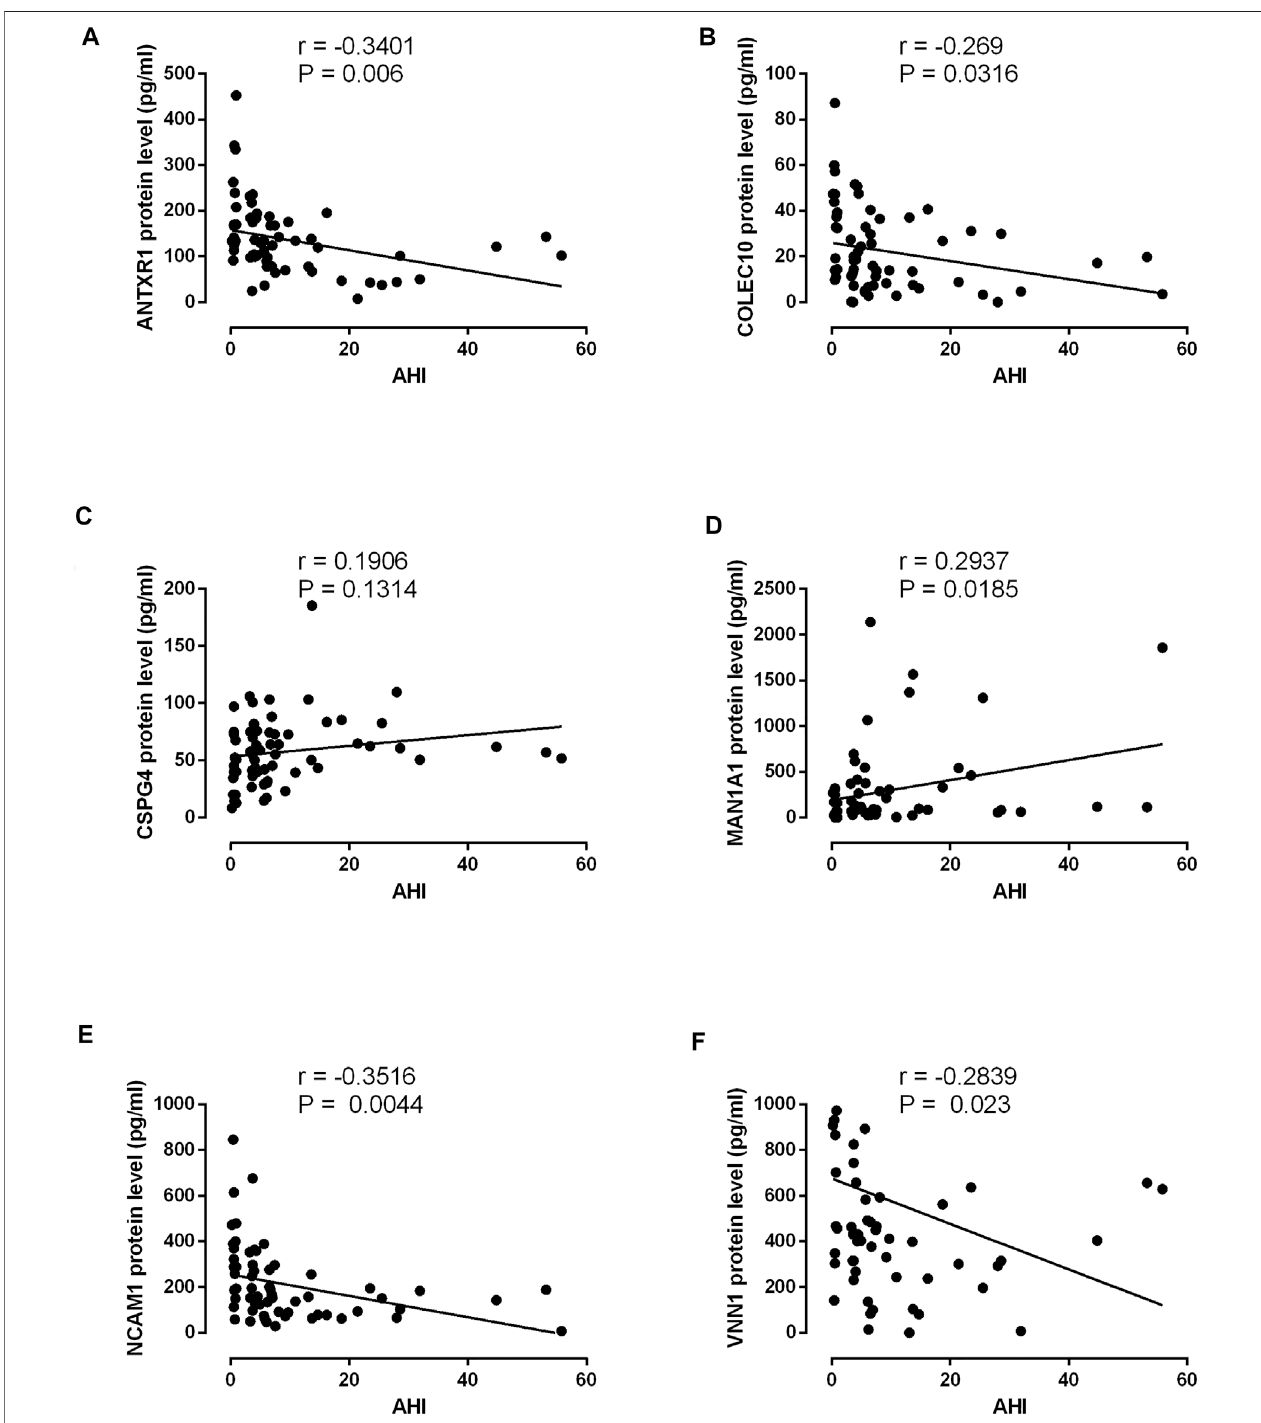
FIGURE10| Correlation analysisbetweenAHI and ANTXR1 (A) ,COLEC10 (B) ,CSPG4 (C) , MAN1A1 (D) ,NCAM1 (E) ,and VNN1 (F) in the64recruited subjects.